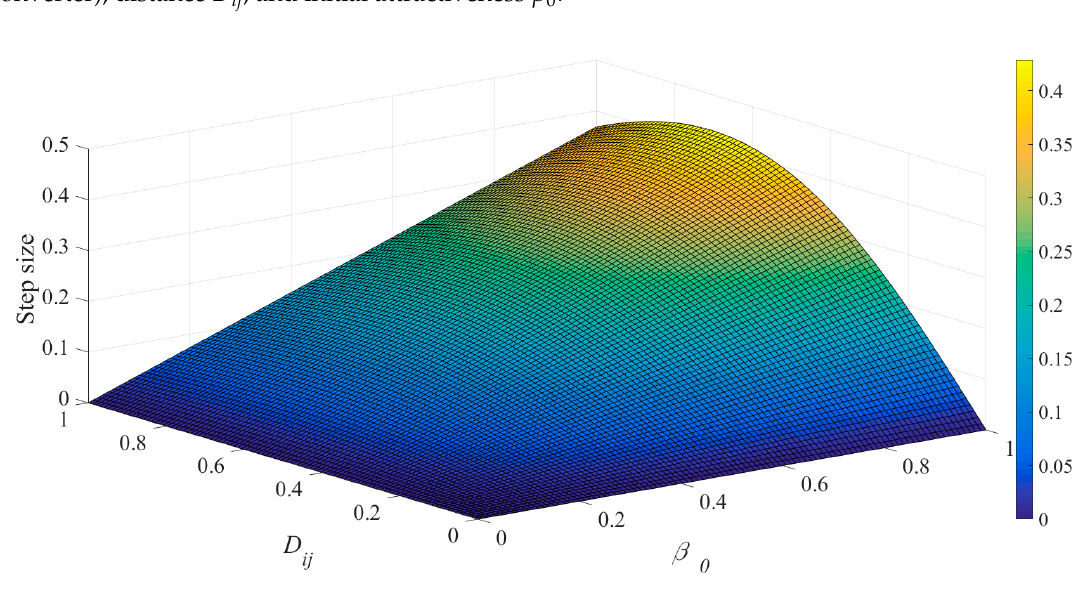
Figure 8. Relationship between the movement step size, distance D ij , and initial attractiveness β 0 in the attraction process.